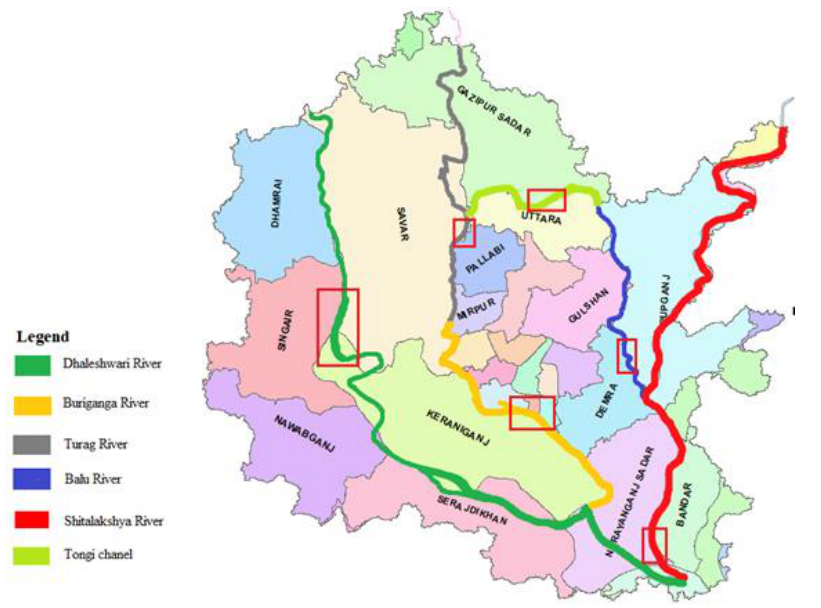
Figure 2. GIS Map Showing Peripheral Rivers around Dhaka city (boxes representing the sampling stretches along the rivers).